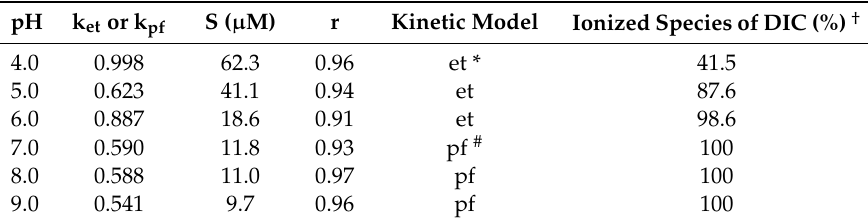
Table 1. Fitting constants (k and S) of the kinetic model under various